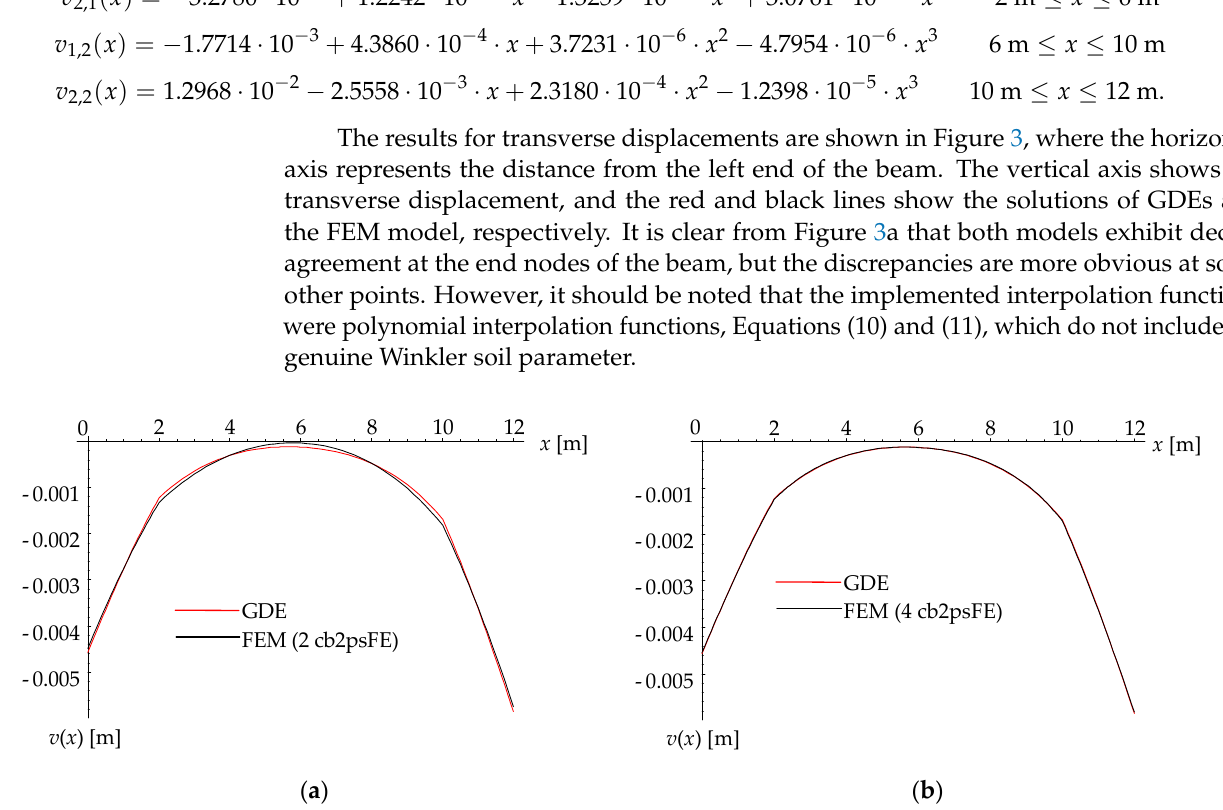
Table 1. Results of transverse displacements for several solutions and locations.